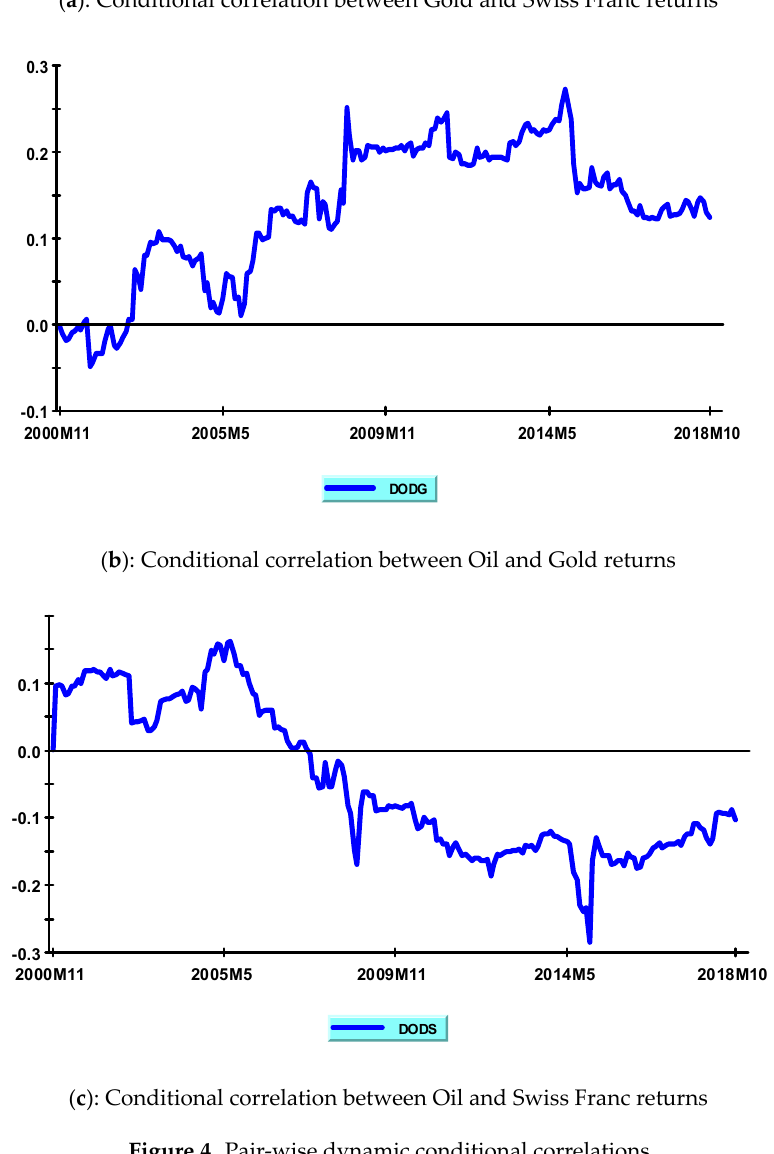
Figure 4. Pair-wise dynamic conditional correlations.